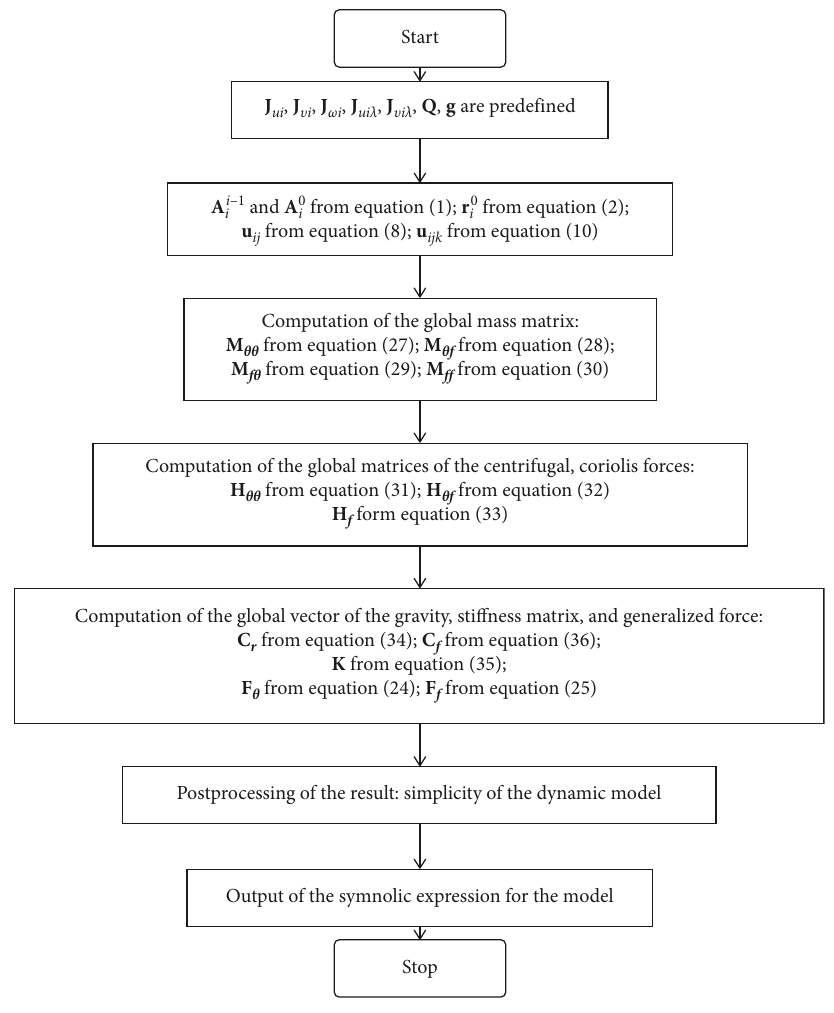
Figure 5: Flowchart of symbolic expressions calculation procedures. Table 1: Required computation time of two modeling methods for different DOF